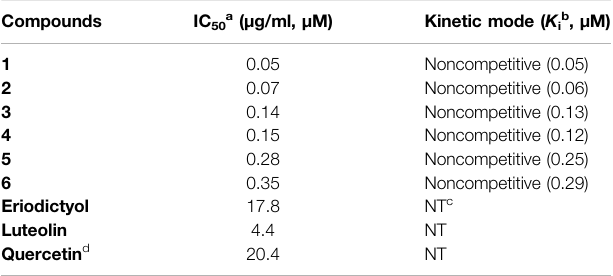
TABLE 1 | Inhibition of bacterial neuraminidase (BNA) by compounds isolated from H. zeylanica . Compounds